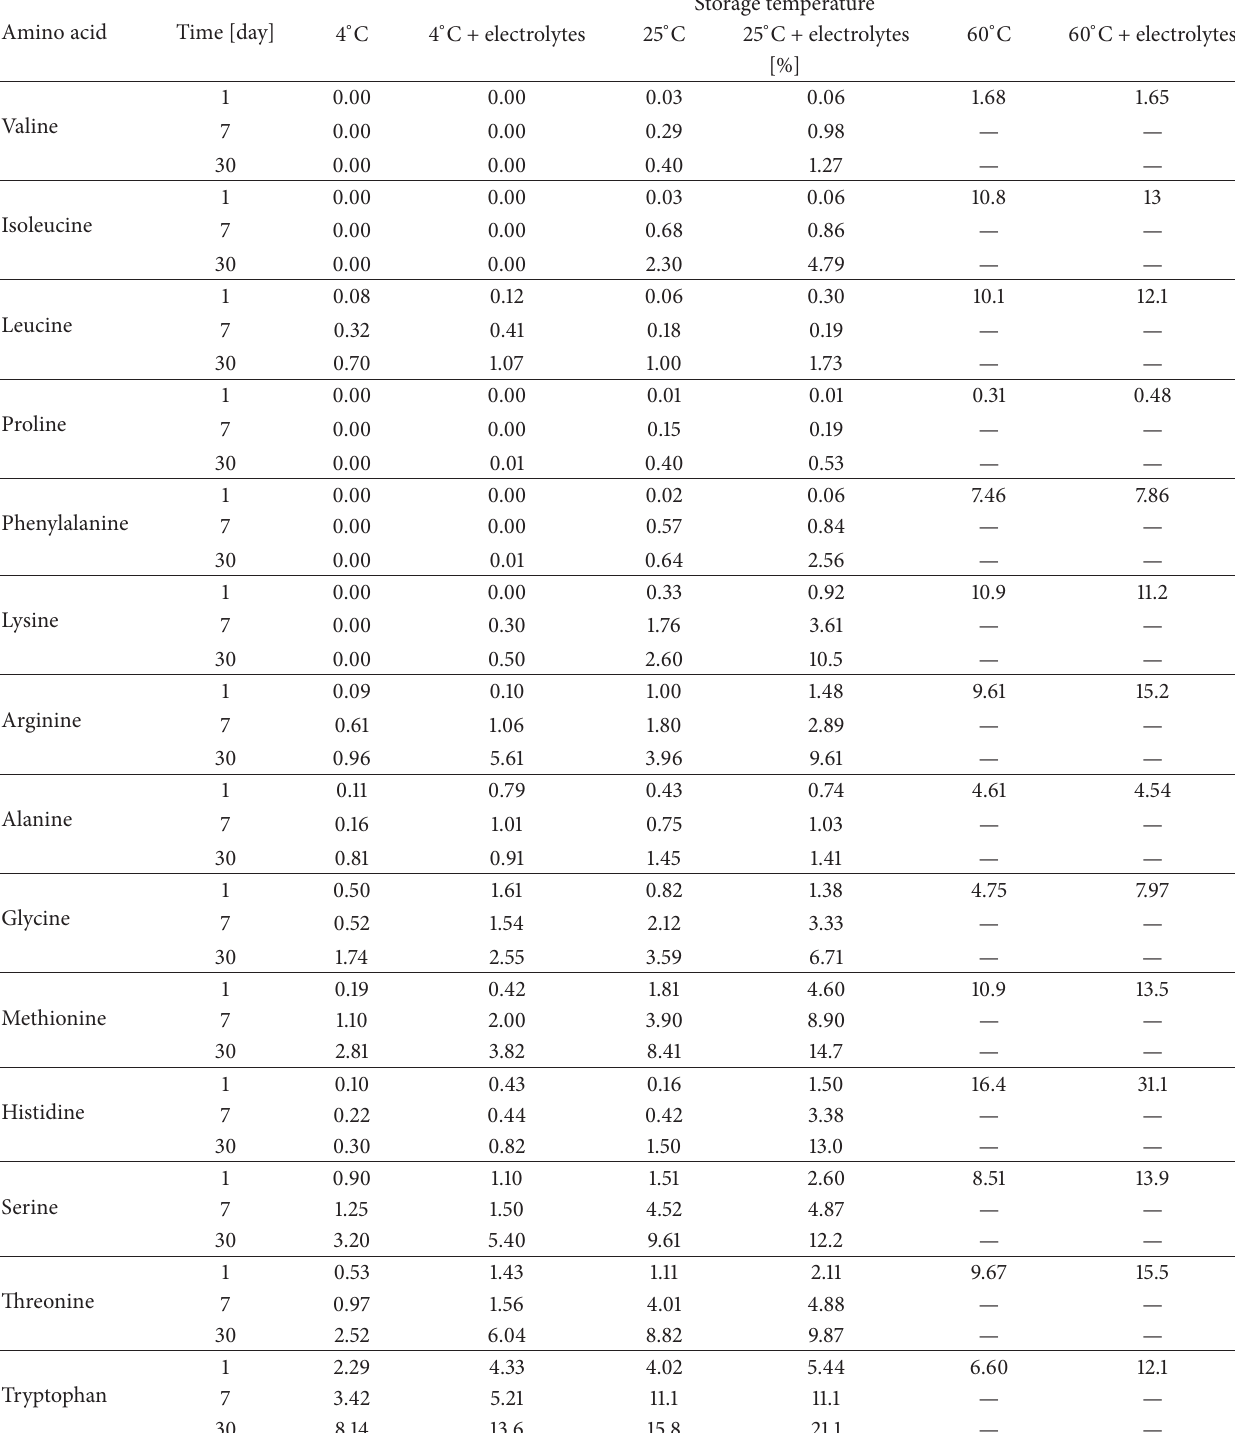
Table 4: Percent of amino acid forming Maillard reaction products